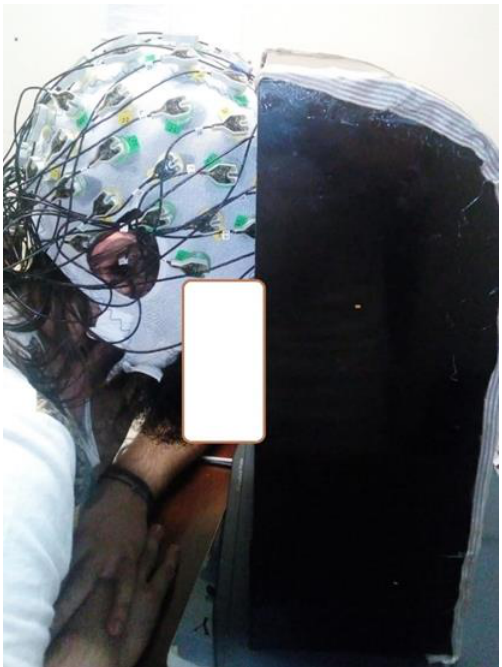
Figure 1. Example of an olfactive task in electroencephalography (EEG). The subject is freely inhaling inside a black box, from which different odourants are administrated through an olfactometer.